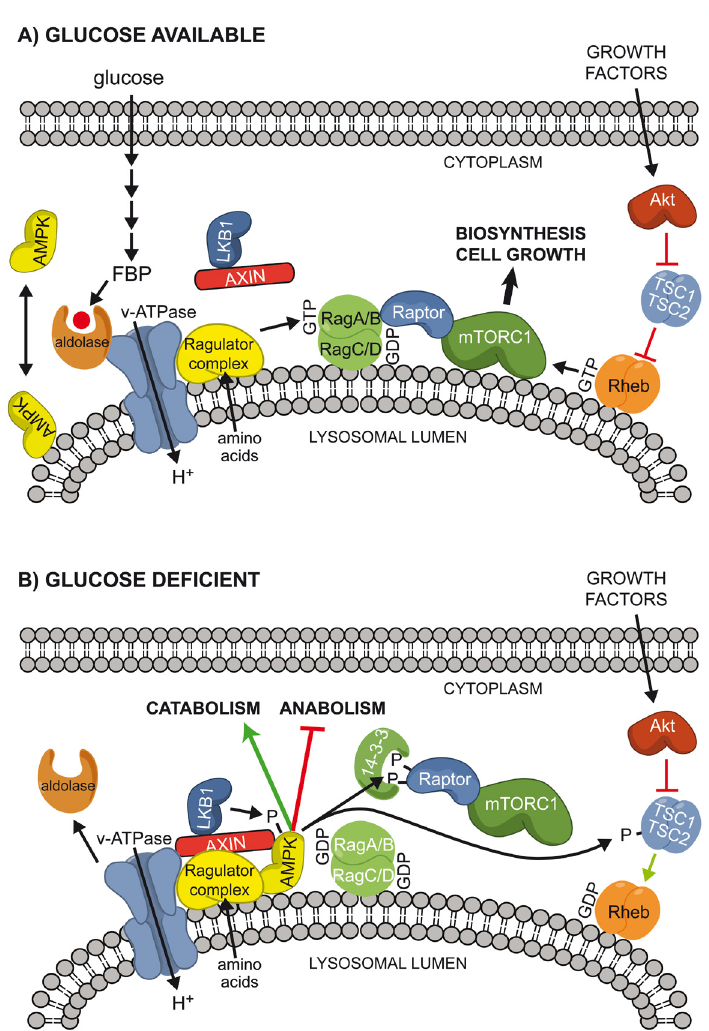
Figure 2. Working model for sensing of glucose availability by AMPK and its potential interactions with the mTORC1 signalling pathway at the lysosome. ( A ) When glucose is present, it is metabolised by glycolysis to FBP, which binds to aldolase and the v-ATPase at the lysosomal surface 41–43 , preventing the interaction of LKB1, AXIN, and AMPK on the lysosome. If amino acids are present (most likely within the lysosomal lumen 78 ), they activate the Ragulator complex, converting the RagA or RagB partner of the Rag heterodimer into its